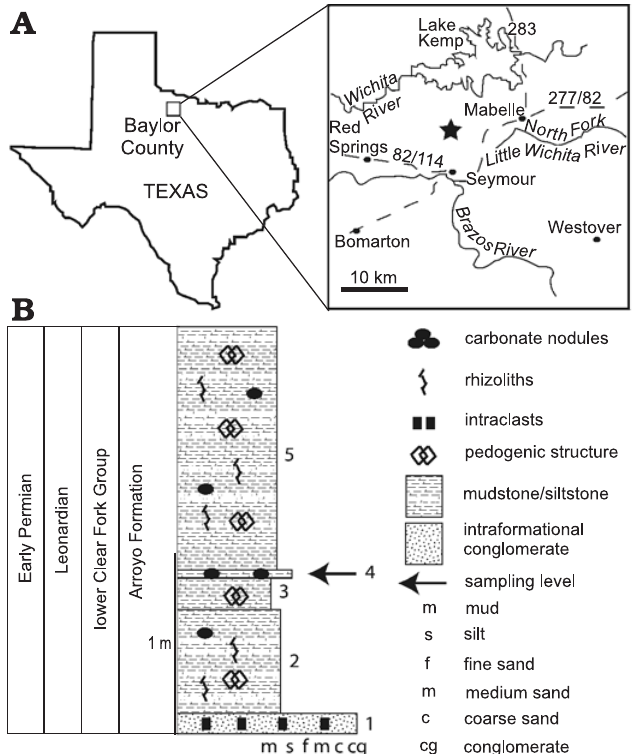
Fig. 1. Baylor County map ( A ) and stratigraphic section ( B ) at the Crad- dock Ranch (denoted with a star), Seymour Texas, lower Clear Fork Formation (cf. Nelson et al. 2013). Numbers 1–5 denote units through the sampled portion of the Craddock Ranch